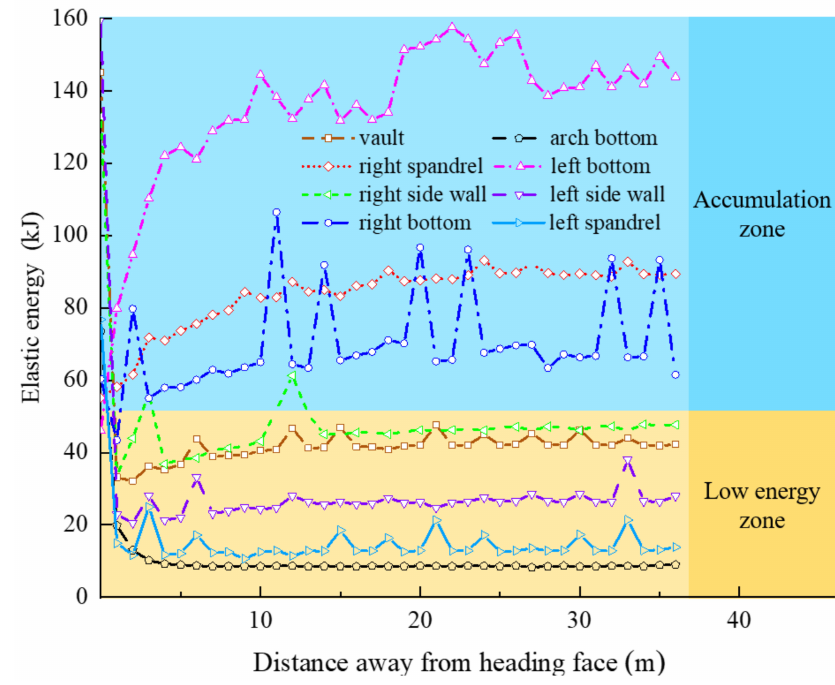
Figure 14. Energy statistics of different measurement